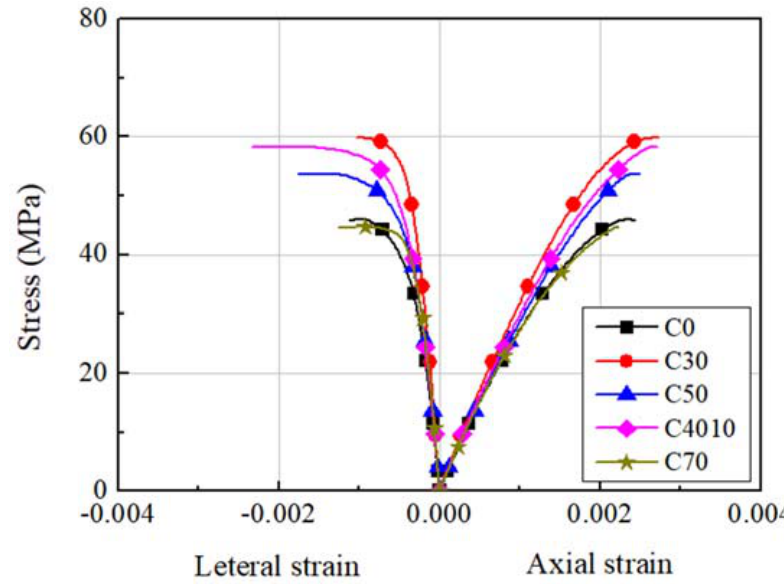
Figure 1. Stress–strain relationships of concrete.